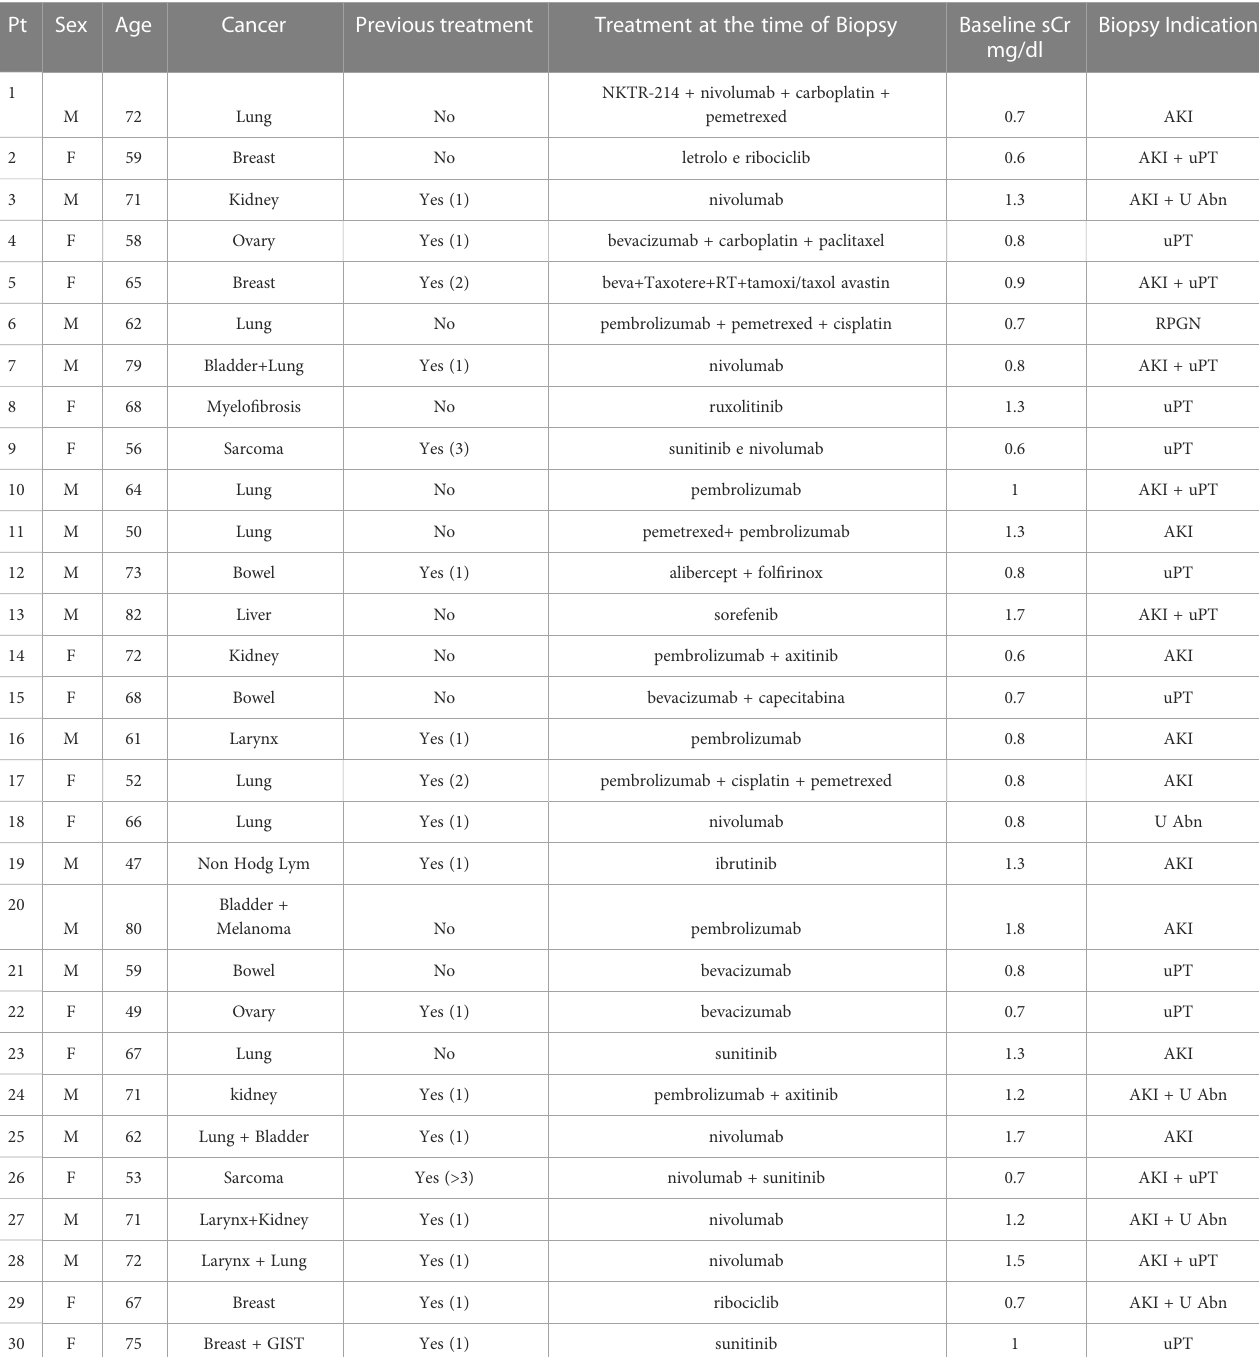
TABLE 1 Demographic and clinical characteristics, treatment at the time of biopsy and biopsy indications. Pt Sex